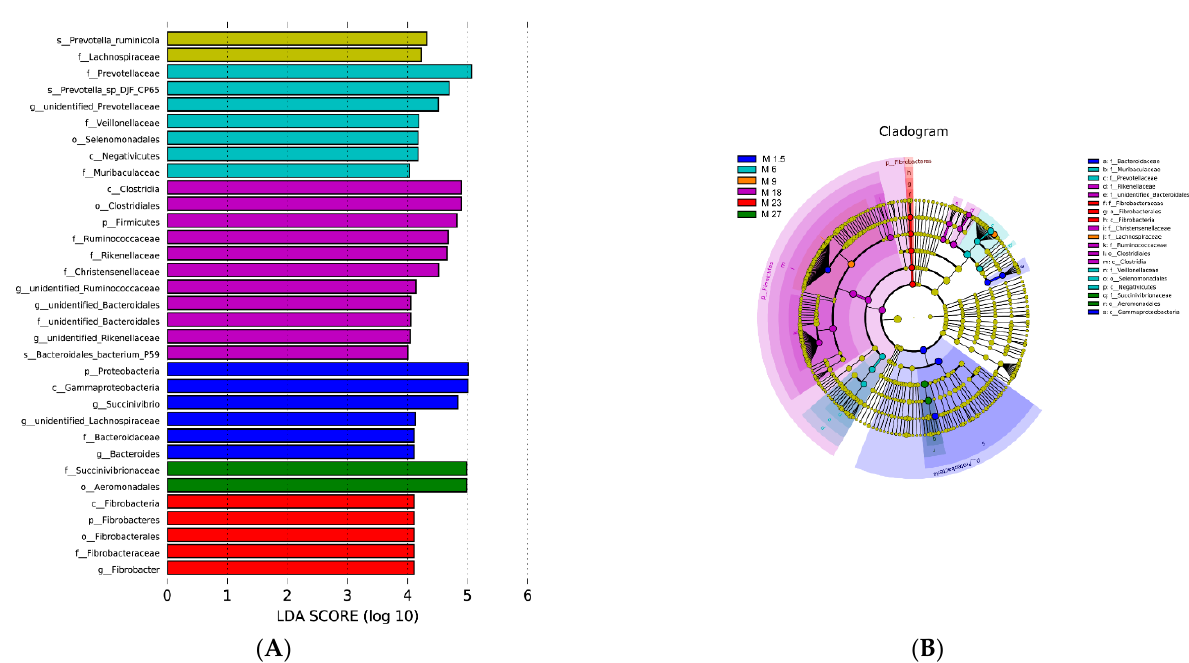
Figure 2. ( A ) Histogram of the LDA scores computed for differentially abundant rumen bacteria across the different ages of dairy cattle. Significant differences are defined as p < 0.05 and LDA score >4.0. ( B ) The LDA effect size (LEfSe) analysis of bacterial taxa within the different ages of dairy cattle. Cladogram shows significantly enriched bacterial taxa (from phylum to genus level).